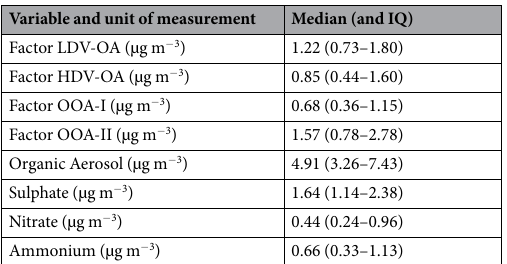
Variable and unit of measurement